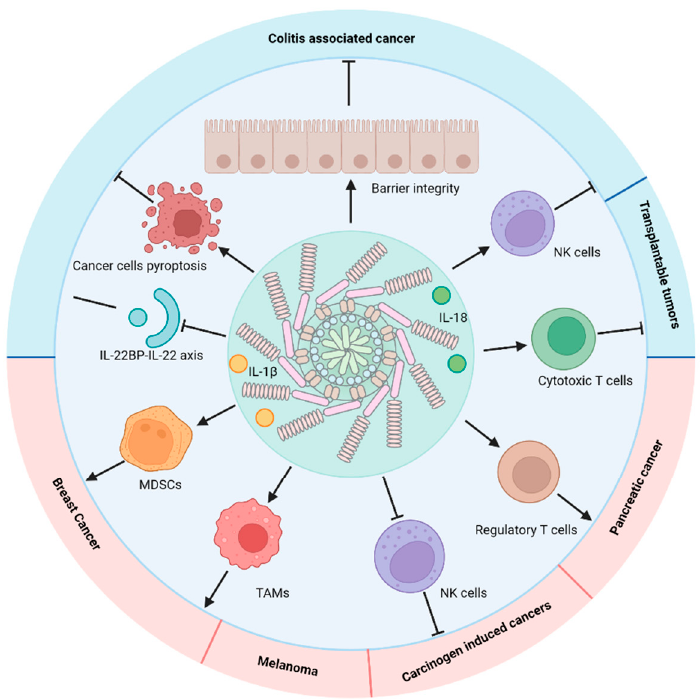
Figure 2. The NF- κ B − NLRP3 inflammasome axis regulates tumorigenesis through modulating the tumor microenvironment. NLRP3 inflammasome-induced IL-1 β production promotes MDSCs’ and TAMs’ infiltration, thereby driving breast cancer progression. NLRP3 could also suppress NK-cell and IFN- γ mediated antitumor responses in carcinogen-induced cancers and melanoma. Moreover, NLRP3 signaling drives pancreatic tumorigenesis by inducing tolerogenic T-cell differentiation and adaptive immune suppression. In contrast to these tumor-promoting effects, the NLRP3 inflammasome also suppresses tumorigenesis. For instance, NLRP3 inflammasome-dependent IL-1 β production by dendritic cells directs an effective CD8 + T cell response against transplantable tumors. In colitis-associated colorectal cancer, NLRP3 inflammasome-induced IL-18 promotes an epithelial barrier healing process to prevent colorectal cancer progression and metastasis. Furthermore, IL-18 can also promote the tumoricidal activity of NK cells against metastasized colonic tumors and directly induce cancer cell pyroptosis. Lastly, NLRP3 inflammasome-dependent IL-18 downregulates the IL-22-binding protein (IL-22BP), whose production fine tunes IL-22 biological activity to regulate colonic tumorigenesis (the figure was created using BioRender).